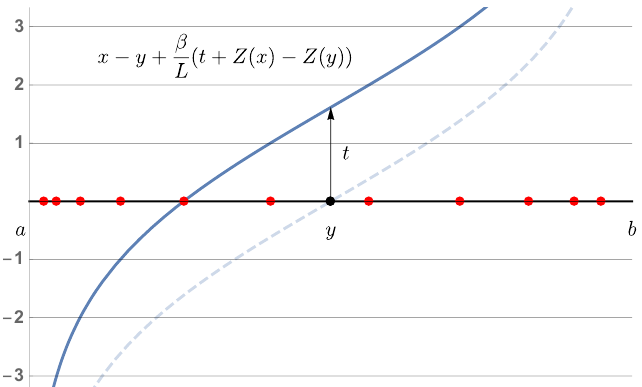
Figure 6 . Modular flow (3.30) for a single interval on the torus. It mixes an operator at y to an infinite but discrete set of points (red) within the interval. These are the intersections of the solid curve with the integers, solutions to (3.28) which accumulate at the endpoints. As modular time increases, these solutions move towards the left endpoint. The dashed opaque curve corresponds to t = 0 , while the solid one is for t > 0 . Note the non-trivial dependence of the curve with the ratio β/L , the two physical scales of the